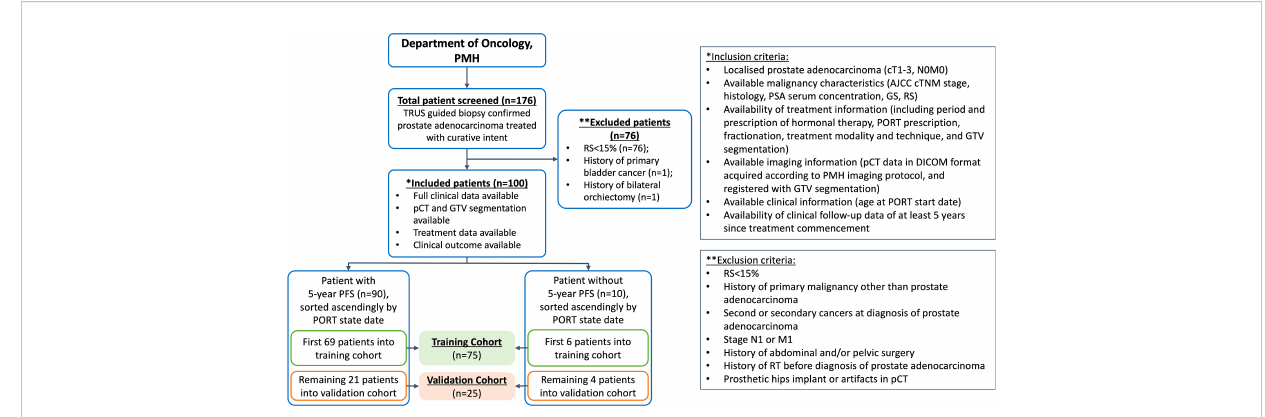
FIGURE 1 Patient strati fi cation and inclusion-exclusion criteria. PMH, Princess Margaret Hospital; n denotes number of patients; TRUS, transrectal ultrasound; RS, Roach Score; pCT, planning computed tomography; GTV, gross tumour volume; PORT, prostate-only radiotherapy; AJCC, American Joint Committee on Cancer; PSA, prostate speci fi c antigen; GS, Gleason